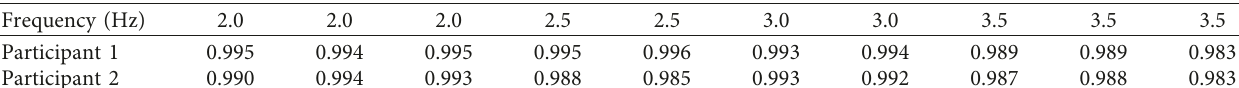
Figure 2: Comparison of the time histories of the accelerations corresponding to the clavicle, the COM, and the equivalent acceleration considering a metronome frequency of 2.5Hz. (a) Time histories; (b) autopower spectral density. Table 2: Correlation values between the clavicle acceleration and equivalent acceleration.